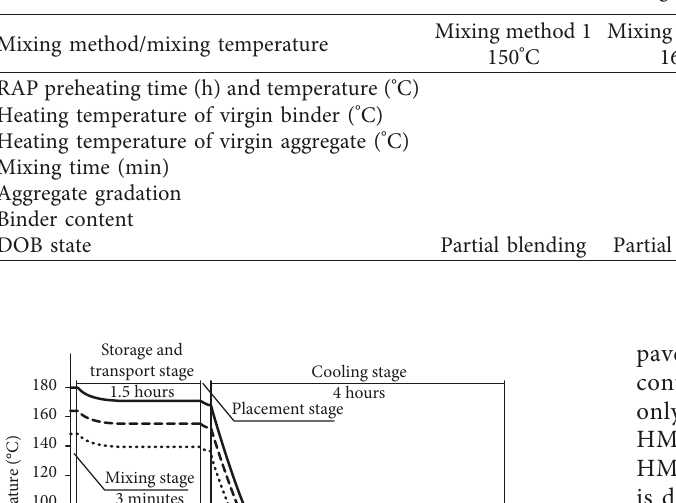
Table 8: Four mixing methods.